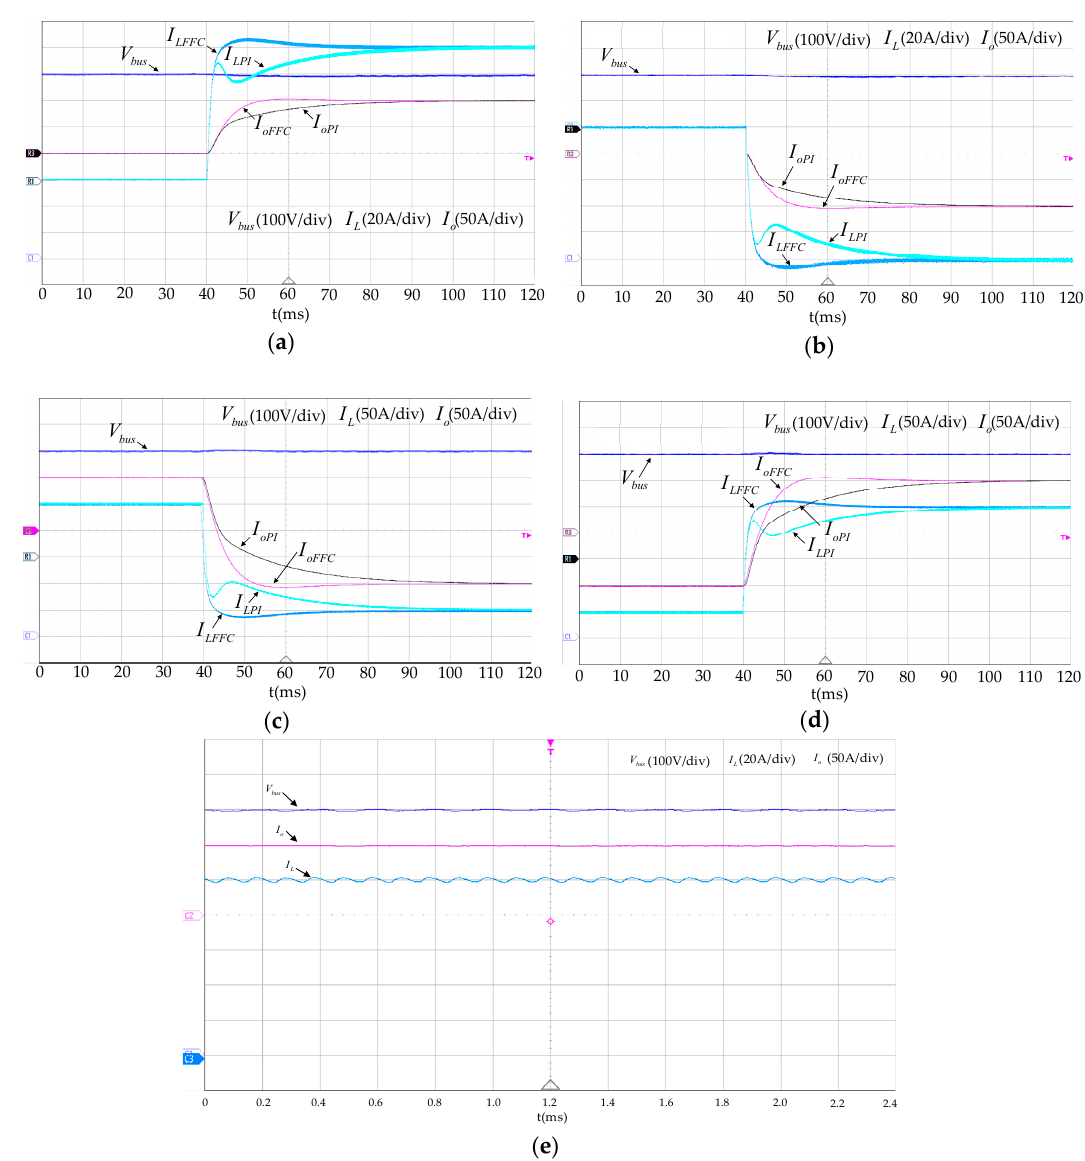
Figure 15. Experiment platform.